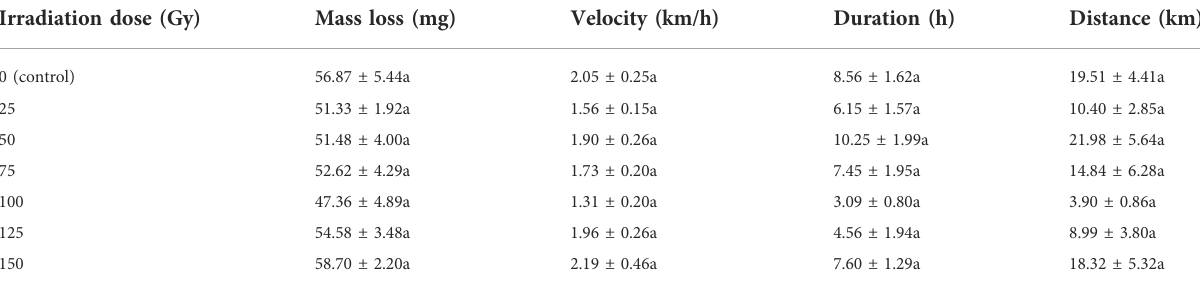
TABLE 2 Means (±SE) for fl ight performance variables of Spodoptera litura adults exposed to different doses of X-ray during pupal stage.